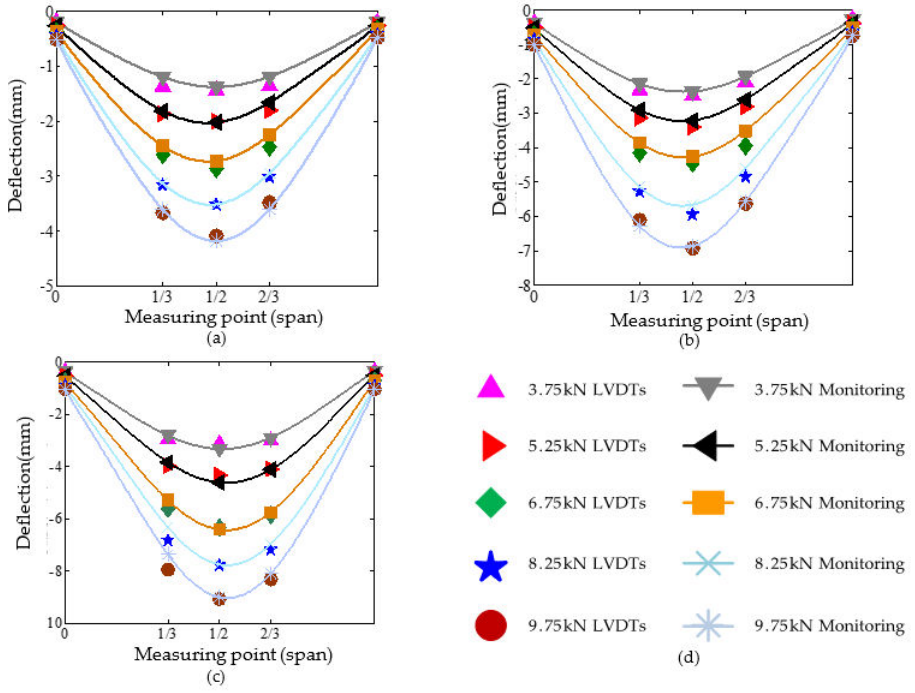
Figure 10. The comparison of beam deflection under uniform loading: ( a – c ) Comparison of L1~L3, respectively; ( d ) Legend of